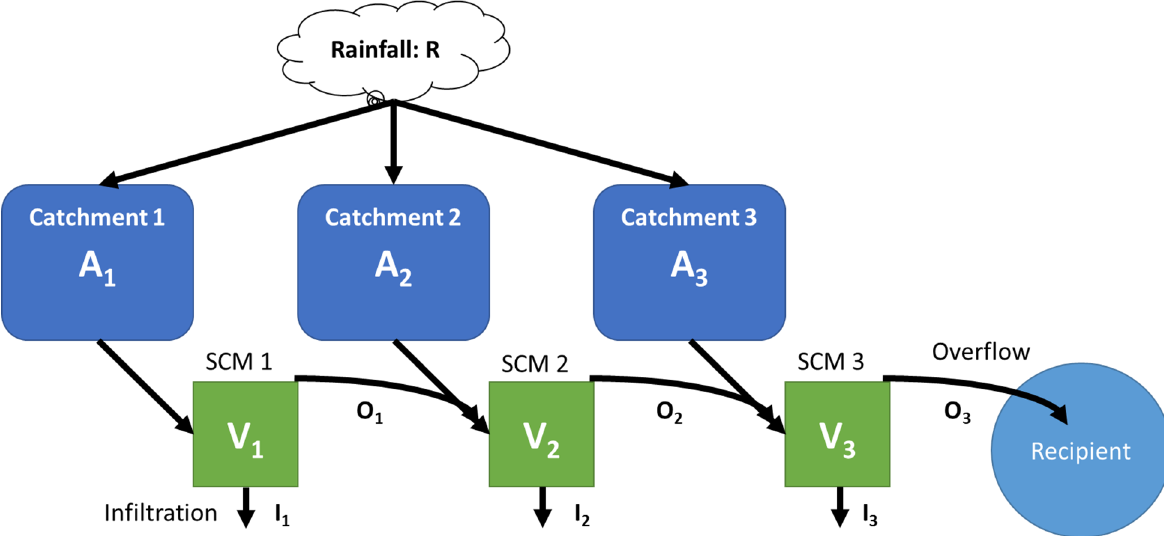
Figure 2. A generalized case study including three sub-catchments, three SCMs and one recipient.